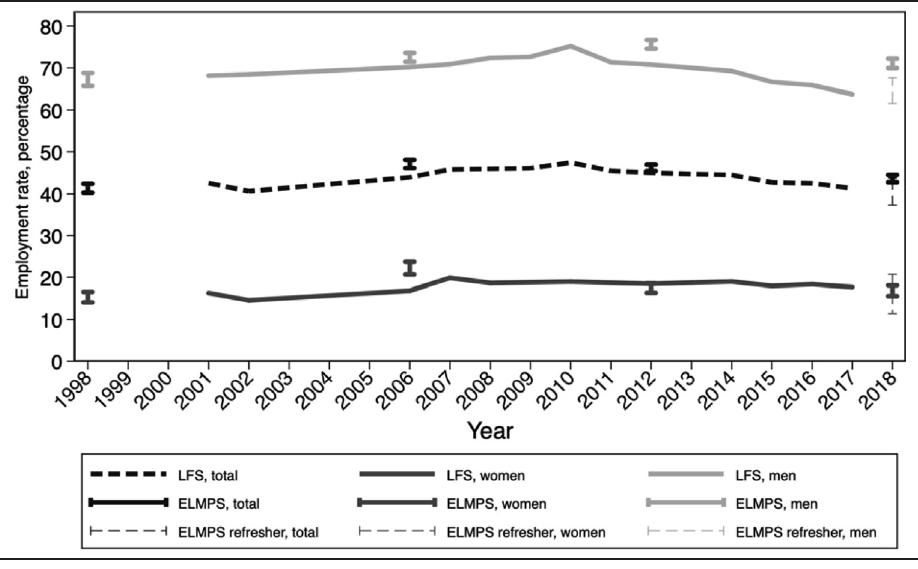
Source : Authors’ calculations from LFS 2008–2017, ELMPS 1998–2018. LFS 2001–2007 from ILOSTAT (ILO, 2019). ELMPS, Egypt Labor Market Panel Survey; ILO, International Labor